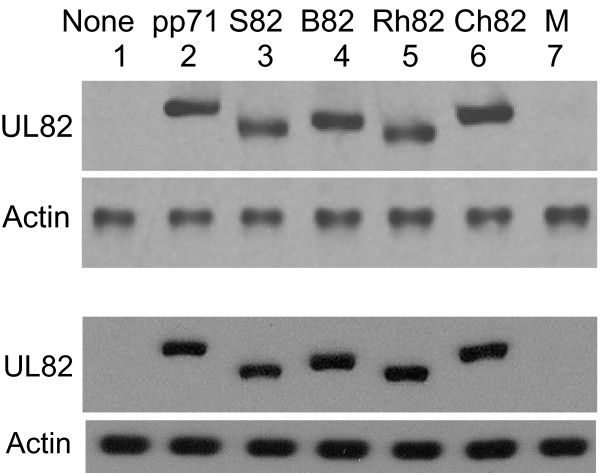
Protein expression by in1312-based recombinants. Monolayers of U373 cells were infected with 1 pfu/cell of in1374-based recombinants that expressed YFP-tagged UL82 homologs and maintained at 38.5°C for 10 h. At this time, extracts were analysed for protein levels, using anti-GFP or anti-actin antibodies as probes. Monolayers were infected with in1374 (lane 1), in1310 (lane 2), in0150 (lane 3), in0145 (lane 4), in0144 (lane 5), in0146 (lane 6) or mock infected (lane 7). Extracts were also analysed for β-galactosidase activity, as described in table 1.